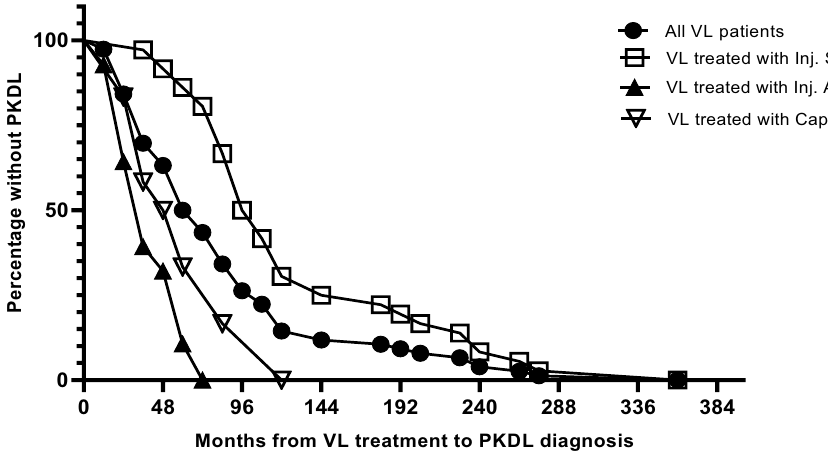
Figure 1. The time (in months) interval from the treatment of visceral leishmaniasis (VL) to being diagnosed as post-kala-azar dermal leishmaniasis (PKDL).